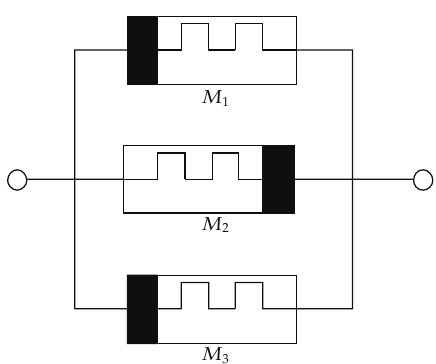
Figure 3: The parallel circuit of three memristors.